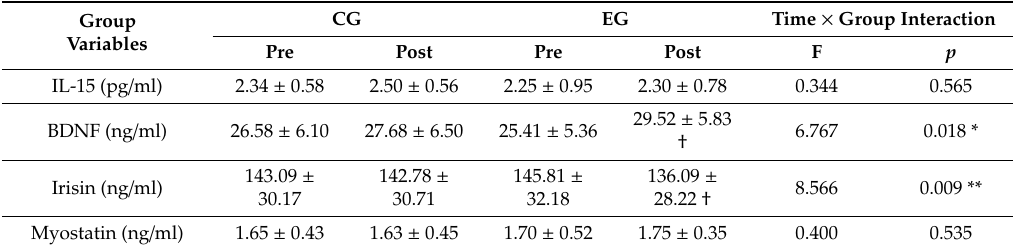
Table 5. Change in myokines over the 16-week